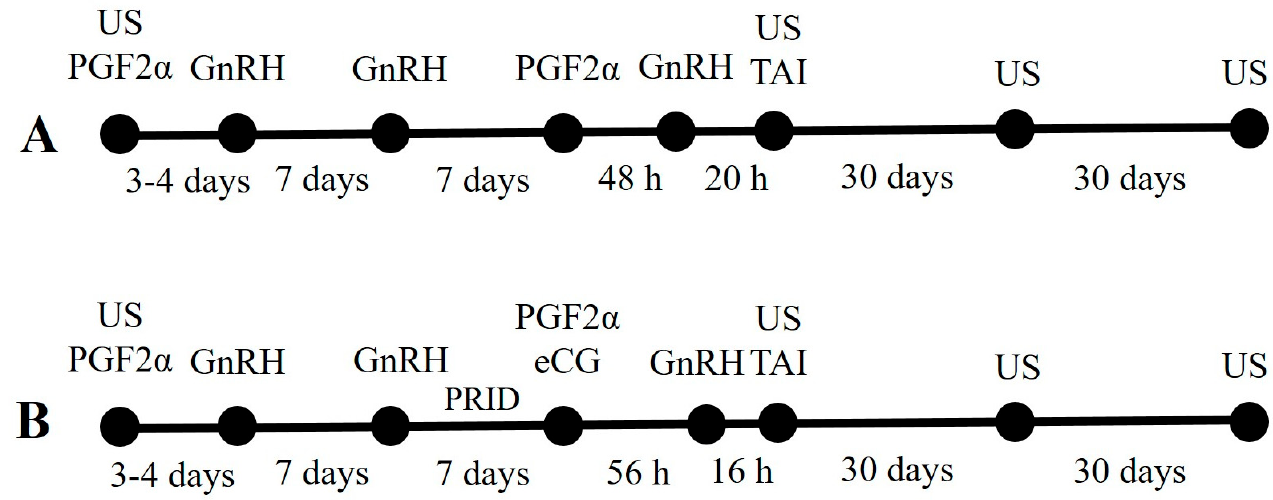
Figure 1. Preselect-OvSynch ( A ) and OvSynch+PRID+eCG ( B ) estrus synchronization protocols in dairy cows (US—ultrasound examination; PGF2 α —prostaglandin F2 alfa; GnRH—gonadotropin-releasing hormone; PRID—progesterone-releasing intravaginal device; TAI—timed artificial insemination).